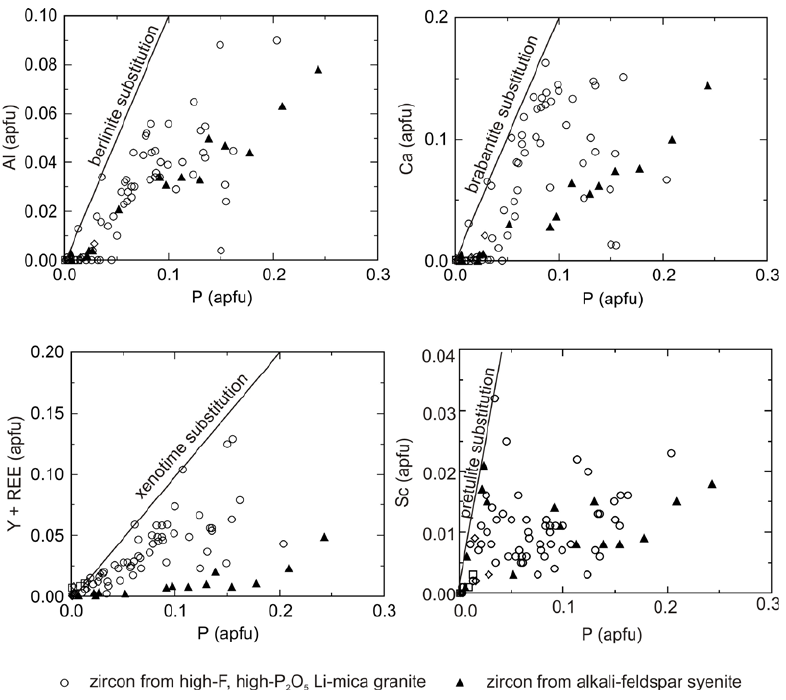
Figure 11. Chemical compositions of zircon from the high-F, high-P 2 O 5 Li-mica granites and alkali-feldspar syenites. ( A ) Distribution Al vs. P. The arrow represent vector of ideal berlinite type (P:Al = 1:1) substitution, ( B ) Distribution Ca vs. P. The arrow represent vector of ideal brabantite-type (P:Ca = 2:1) substitution, ( C ) Distribution of Y and REE vs. P. The arrow represent vector of ideal xenotime-type (P:(Y + REE) = 1:1) substitution, ( D ) Distribution Sc vs. P. The arrow represent vector of ideal pretulite-type (P:Sc = 1:1) substitution